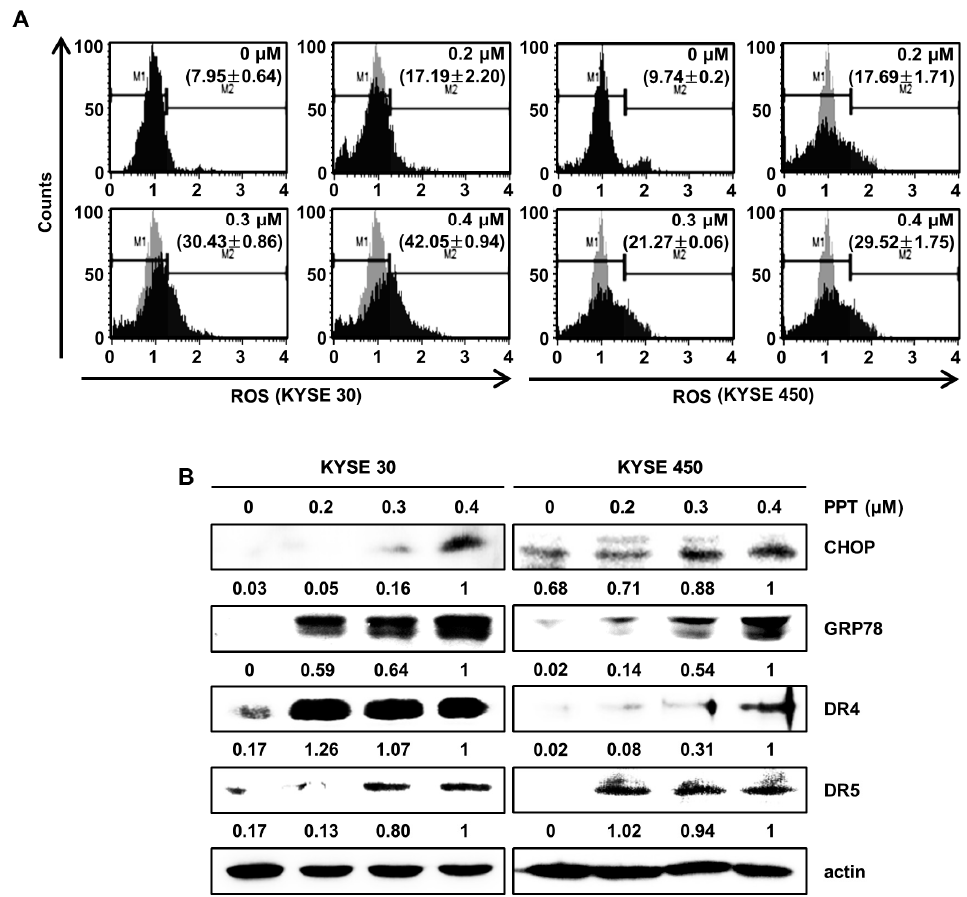
Figure 4. PPT provokes apoptosis by the generation of intracellular reactive oxygen species (ROS) and the regulation of endoplasmic reticulum (ER) stress-related proteins. ESCC cells (KYSE 30 and KYSE 450) were treated with PPT of 0.2, 0.3 and 0.4 µM or DMSO for 48 h. ( A ) Intracellular ROS was assayed using fluorescent dyes and Muse™ Oxidative Stress Reagent (Merck Millipore); n = 4. ( B ) The expression of ER stress-related proteins, including GRP78, C/EBP homologous protein (CHOP), DR4, and DR5, in PPT-treated ESCC cells was analyzed by Western blots. Actin served as a loading control.